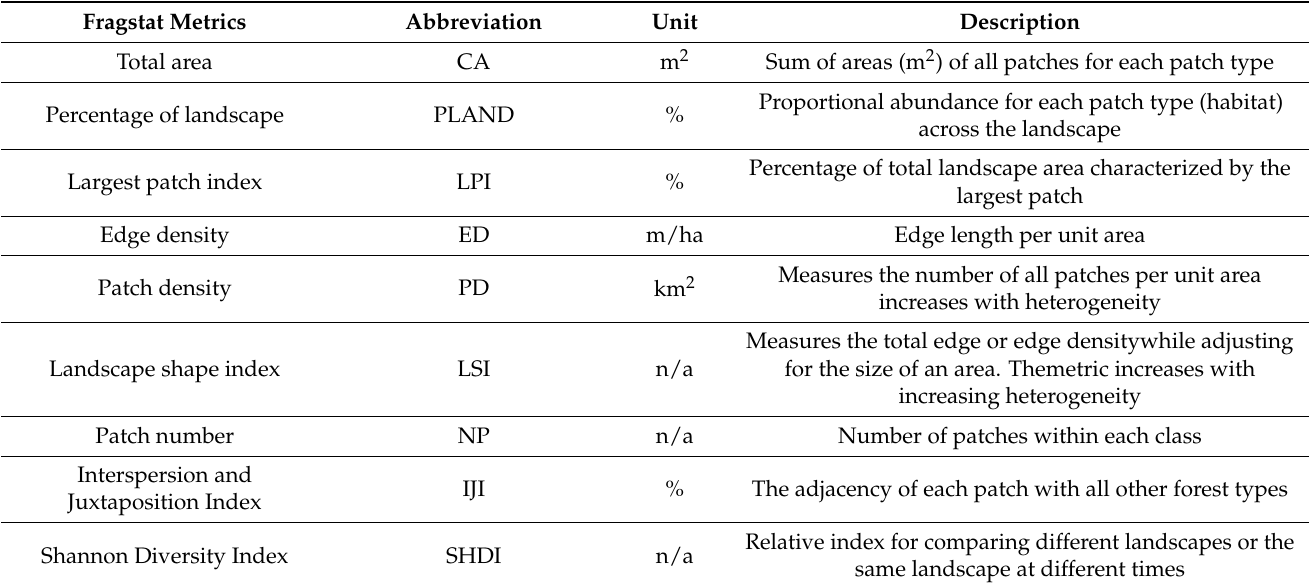
Table 4. Different landscape metrics types that we assessed in this study for the Wami Mbiki–Saadani wildlife corridor, Tanzania, from 1998, 2008, and 2018, according to the descriptions used by Fragstat [68].